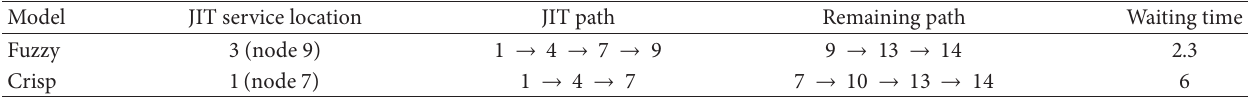
Table 4: Comparison of the results.